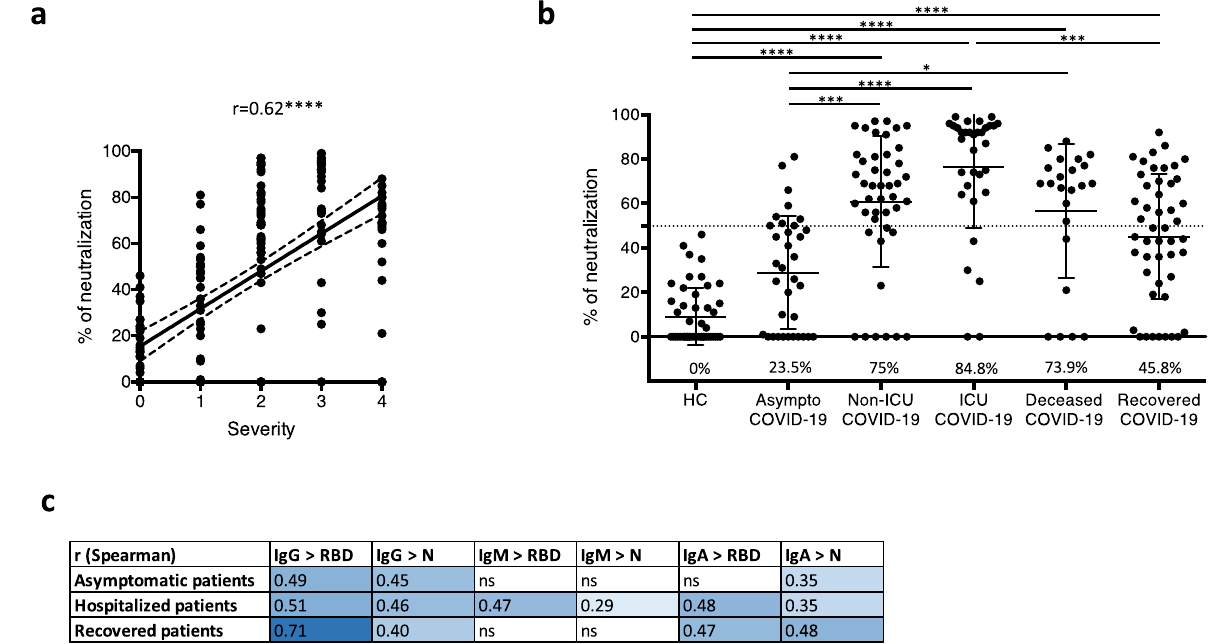
Figure 2. Correlation of spike-pseudotyped lentiviral neutralization, disease severity and serology results. ( a ) COVID-19 patients were classified according to their disease severity (0 = healthy controls, 1 = asymptomatic COVID-19 patients, 2 = hospitalized non-ICU COVID-19 patients, 3 = ICU COVID-19 patients, 4 = deceased COVID-19 patients). Correlation between spike-pseudotyped lentiviral neutralization and severity was assessed with simple linear regression (solid line) and 95% confidence bands (dashed line) of the best-fit line. The Spearman’s correlation coefficient (r) is shown. ( b ) The neutralization capacity in serum or plasma of healthy controls and COVID-19 patients was determined by spike-pseudotyped lentiviral neutralization assay and was expressed in terms of a percentage of neutralization. The six patient cohorts are presented in Table 1. The percentage of neutralizing samples is indicated. Samples were considered neutralizing when neutralization capacity was greater than 50% (dashed line). ( a , b ) Each dot represents one sample. * p < 0.05, *** p < 0.001, **** p < 0.0001 (Kruskal Wallis test and Dunn’s multiple comparisons test). ( c ) Correlations between spike- pseudotyped lentiviral neutralization and titers of IgG, IgM and IgA directed against RBD or N were assessed for asymptomatic COVID-19 patients, hospitalized COVID-19 patients (including non-ICU, ICU and deceased COVID-19 patients) and recovered patients. Spearman’s correlation coefficients (r) are shown and visualized by colour intensity. All correlations are significant ( p < 0.05) except those indicated by